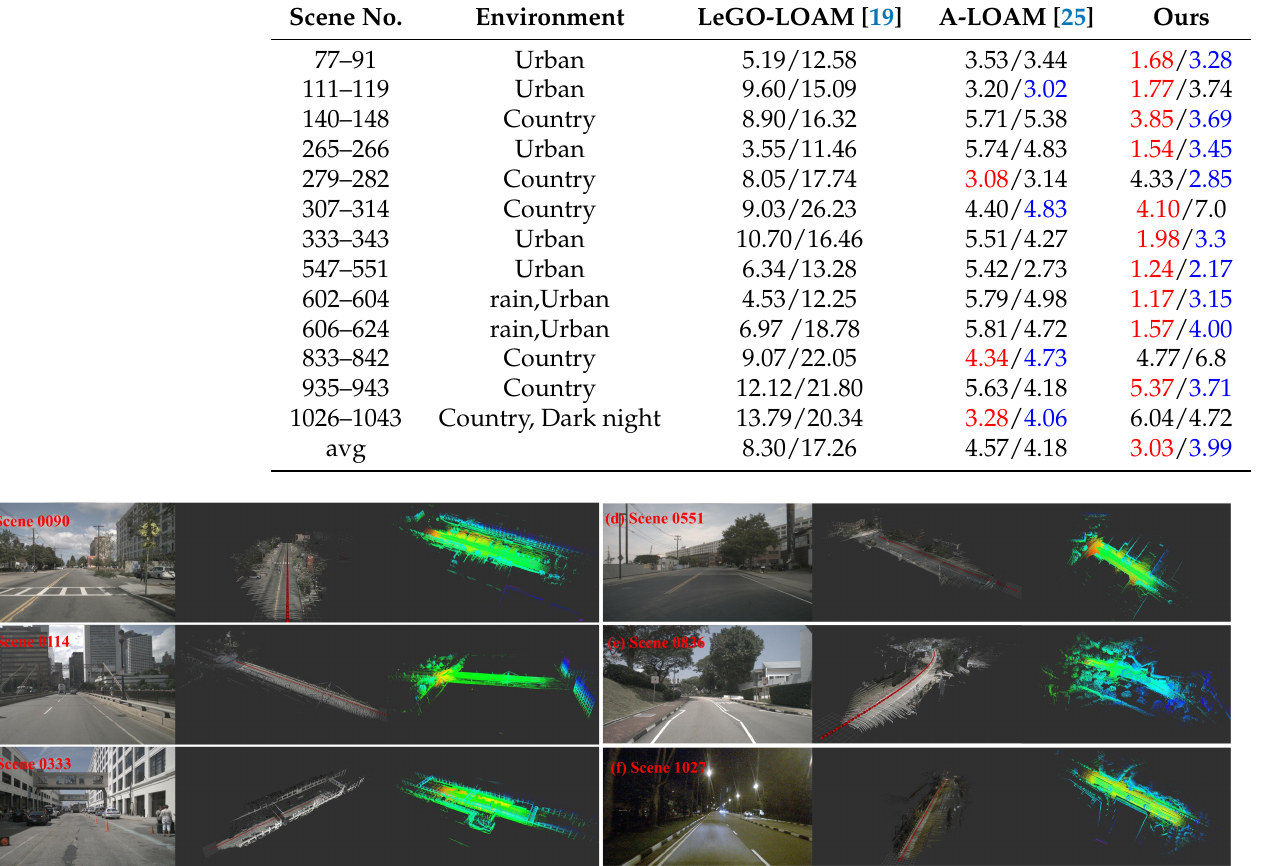
Figure 16. Mapping results of some representive scenes in nuScenes dataset. In each column, from left to right are sample image in the scene, point cloud map color-encoded with images, and total LiDAR point cloud map, respectively. Where the red spheres in the middle represent the estimated trajectory of the